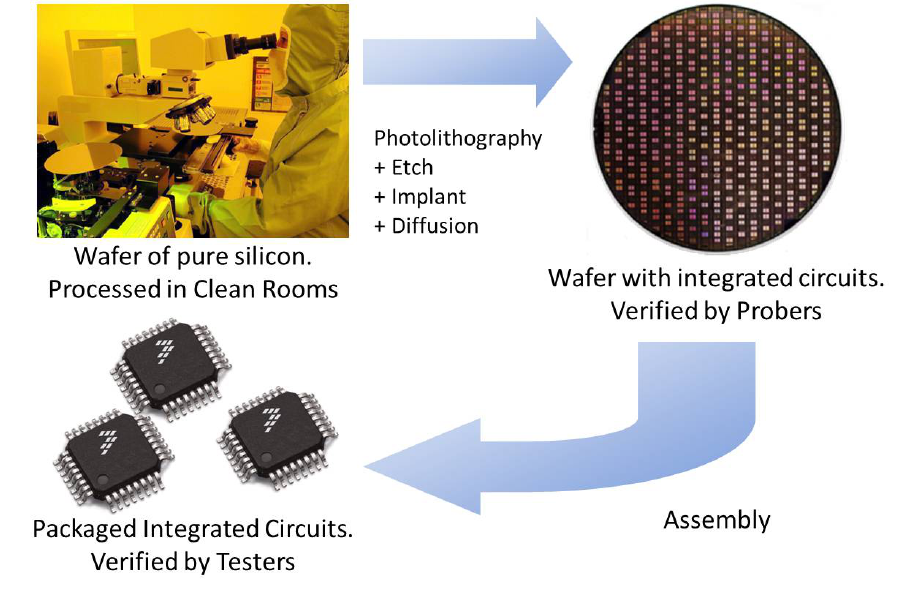
Figure 2. Semiconductor manufacturing